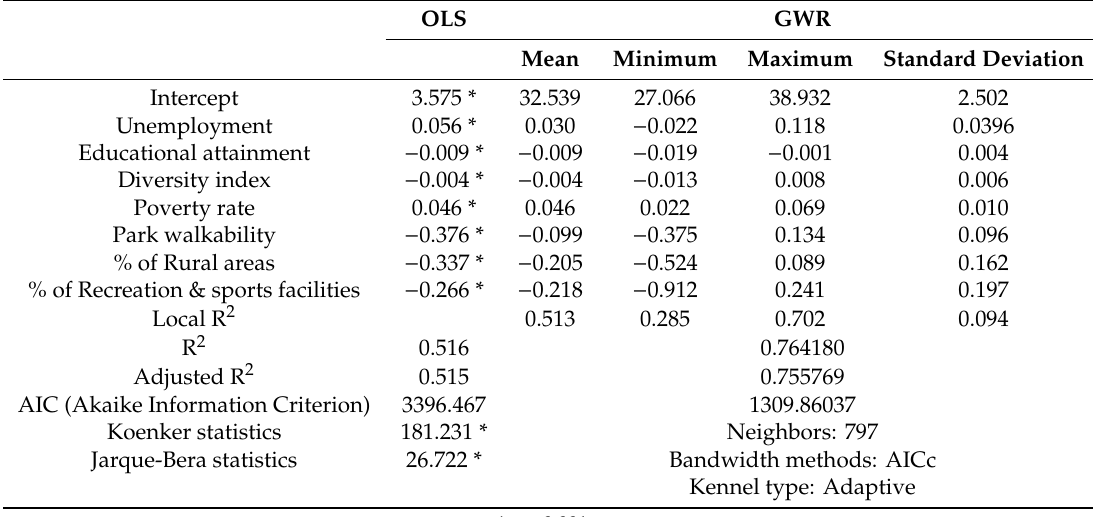
Table 3. Comparison results between ordinary least squares (OLS) and geographically weighted regression (GWR). OLS GWR Mean Minimum Maximum Standard Deviation Intercept 3.575 * 32.539 27.066 38.932 2.502 Unemployment 0.056 * 0.030 − 0.022 0.118 0.0396 Educational attainment − 0.009 * − 0.009 − 0.019 −